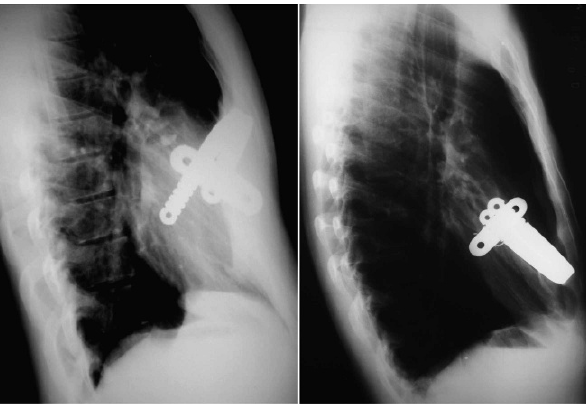
Figure 1 - A and B: Examples of bar displacement.